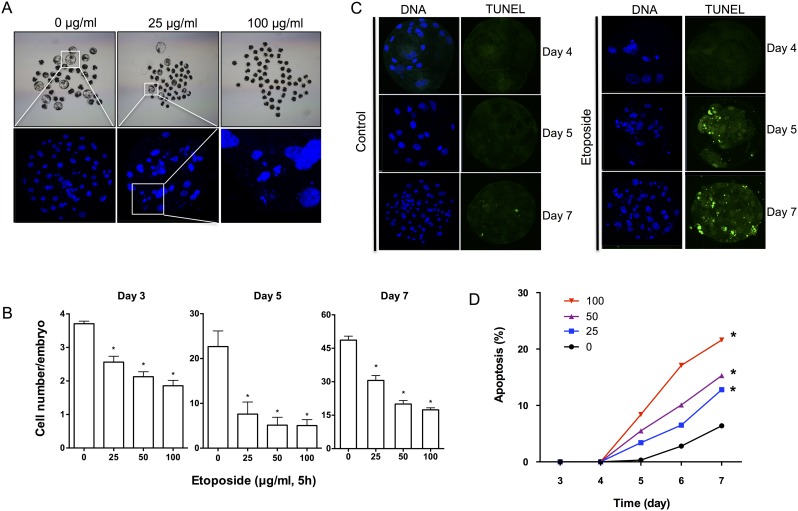
Etoposide treatment resulted in poor-quality embryos.(A) Schematic diagram of 7-day-old embryos. The blastocyst rates and cell numbers were lower after 25 and 100 μg/mL etoposide treatment. We found that the etoposide-treated embryos contained multiple micronuclei. (B) Cell numbers in etoposide-treated (0, 25, 50, 100 μg/mL) embryos fixed on day 3, 5, and 7 of culture. Data are from three independent replicates and at least 20 embryos were analyzed in each experiment. (C) TUNEL-positive cells were detected in etoposide-treated (25 μg/mL) embryos at day 5 of culture and TUNEL staining further increased by day 7. (D) Apoptotic rate (number of apoptotic cells/number of total cells) in embryos from day 3 to day 7. Embryos were not treated (control) or treated with 25 μg/mL etoposide. Asterisks denote a significant difference from unexposed controls (* p < 0.05). Values are means ± SD of 3 independent experiments.